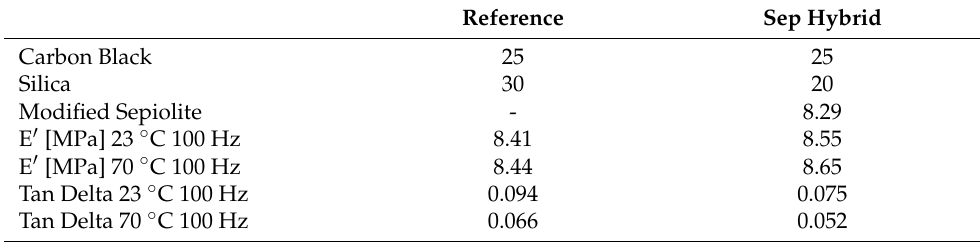
Table 3. The use of sepiolite in hybrid networks with silica and carbon black allows reducing compound hysteresis, the main contributor of the tire rolling resistance coefficient. Filler amounts expressed in parts per hundred rubber (p.h.r.). Full recipe available in ref.